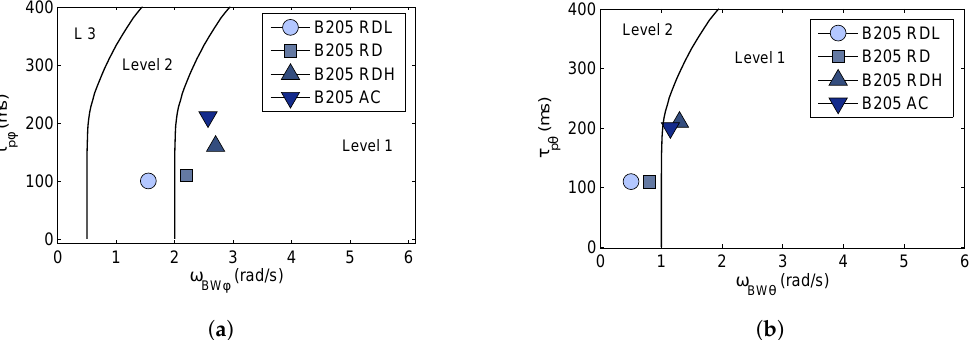
Figure 3. NRC Bell 205 calculated bandwidth plotted against ‘All Other mission task element (MTE)’ boundaries, ( a ) roll axis; ( b ) pitch